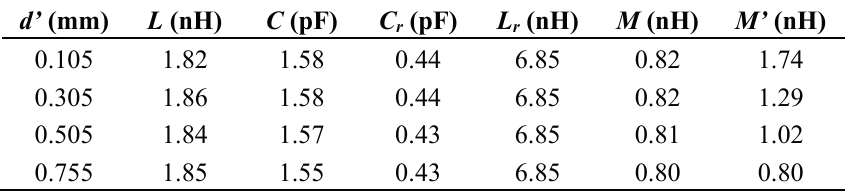
Figure 16. Variation of the notch frequencies as a function of d’ for the asymmetric SRR-loaded CPW ( a ), and detail of the fabricated sample (bottom face) for d’ = 0.105 mm ( b ). From [26]; reprinted with permission IEEE 2015. Table 2. Extracted circuit parameters (symmetric case) for different values of d’